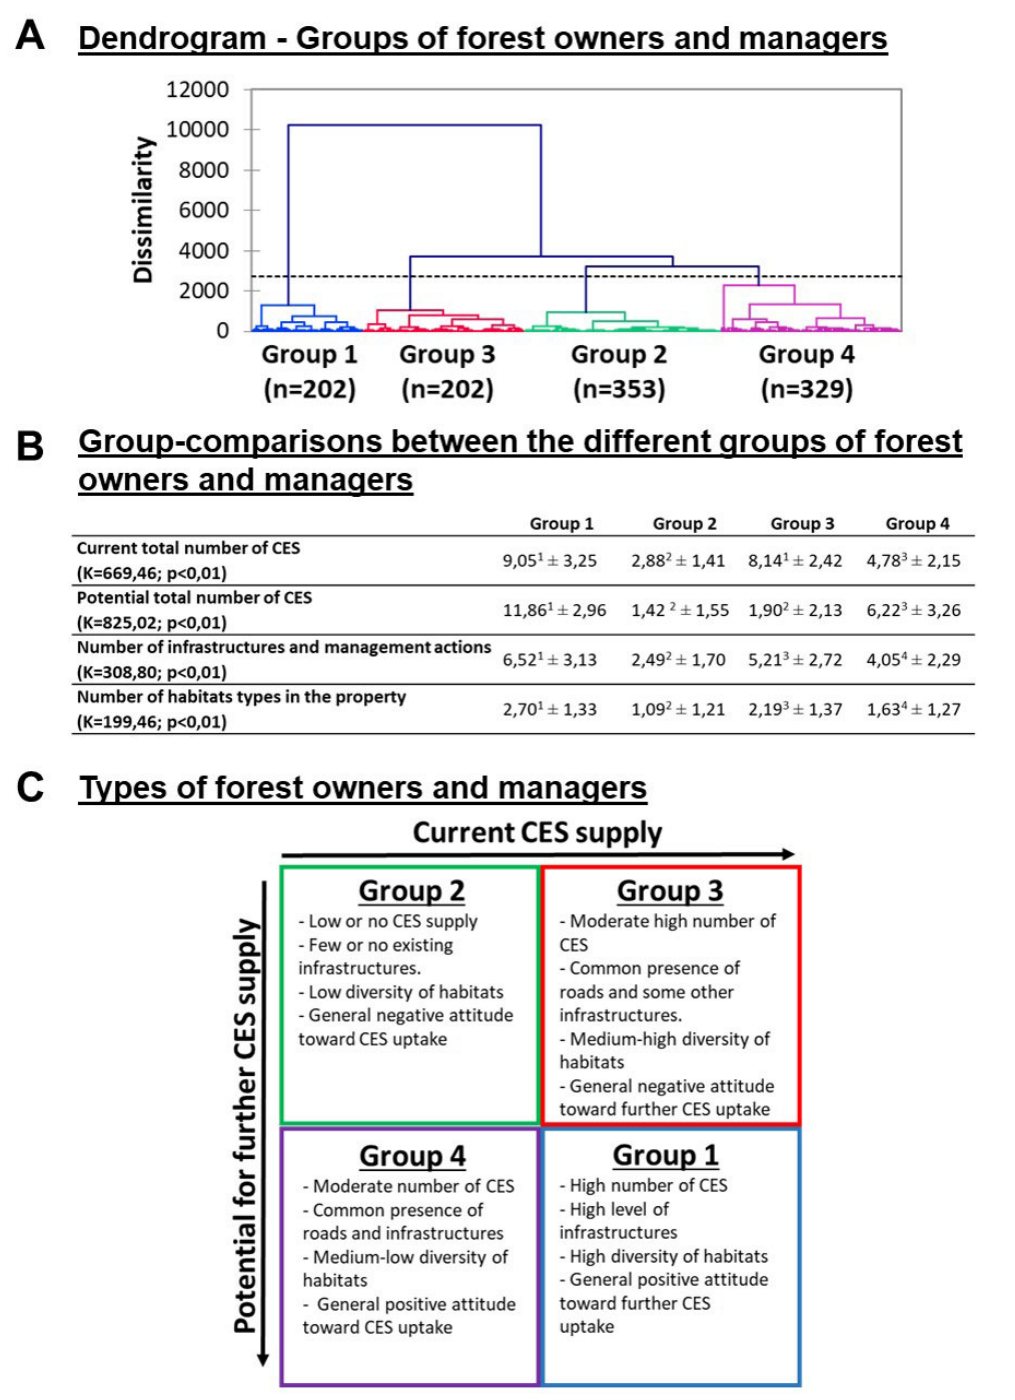
Fig. 3 . Types of forest owners and managers. (A) Dendrogram classifying forest owners and managers in four main groups based on their attitudes toward current cultural ecosystem services (CES). (B) Group comparisons (Kruskal-Wallis tests) between the different groups of forest owners and managers. For each variable, groups with significant different mean (p < 0.05) have a different superscripted number. (C) Characterization of the four groups of forest owners and